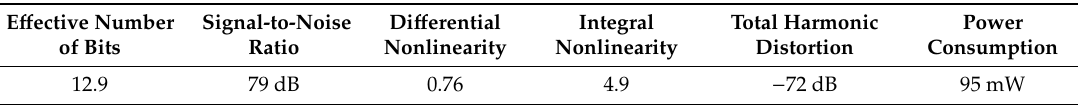
Table 3. Parameters of a 14 bits on-chip pipeline analog-to-digital convertor (ADC) designed for microbolometer IRFPA